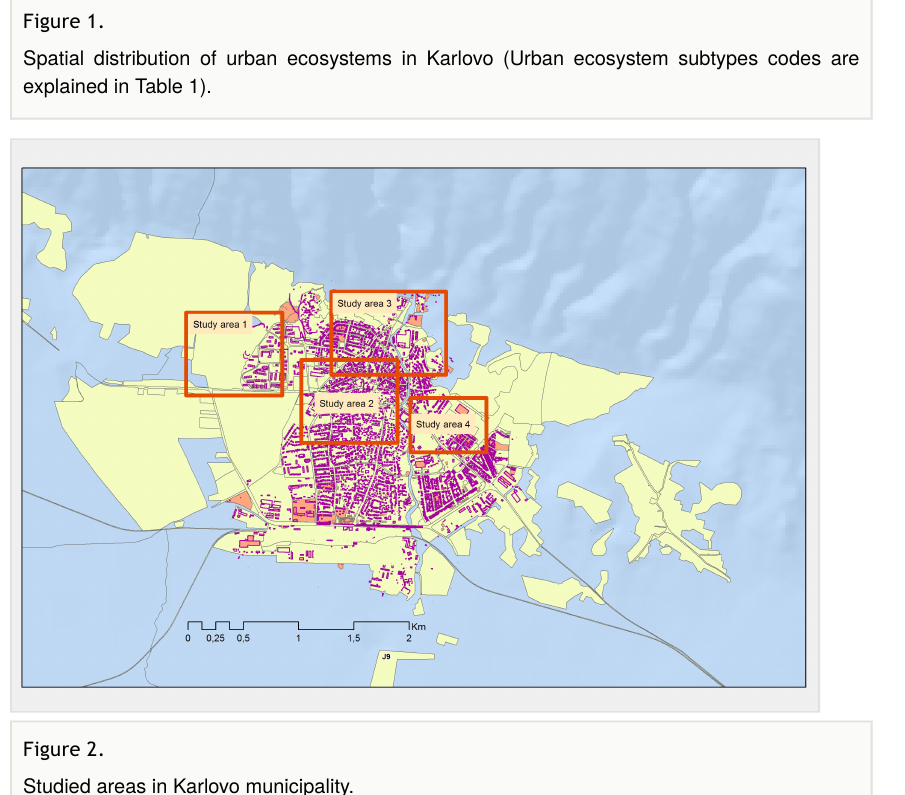
Figure 2. Studied areas in Karlovo